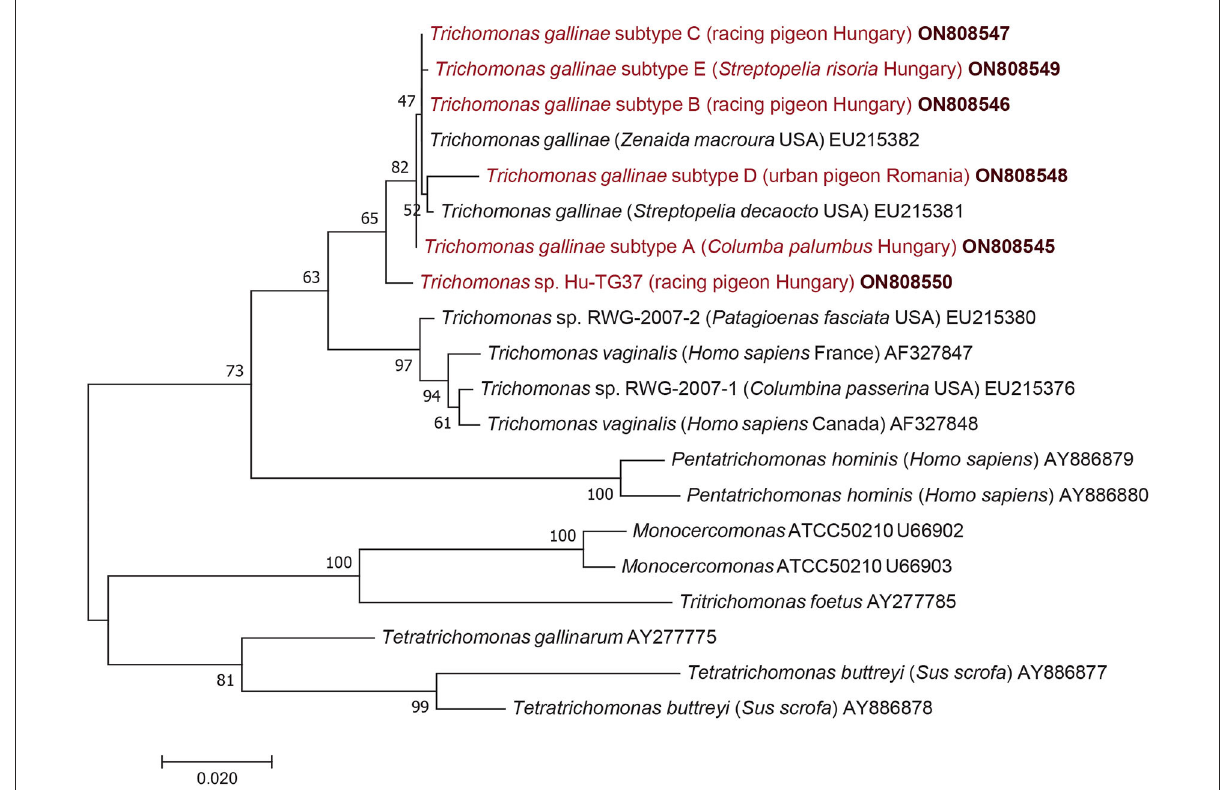
FIGURE2 Phylogenetic tree of Trichomonadea based on the alpha-tubulin gene, made with the maximum likelihood method and the Jukes-Cantor model. In each row, after the species or genus name, the isolation source, for species closely related to Trichomonas gallinae the country of origin and the GenBank accession number are shown. Sequences obtained in this study and representing each subtype are in red and bold accession numbers. The analysis involved 20 nucleotide sequences and 1,000 bootstrap replications. There were a total of 977 positions in the final dataset. The scale-bar indicates the number of substitutions per